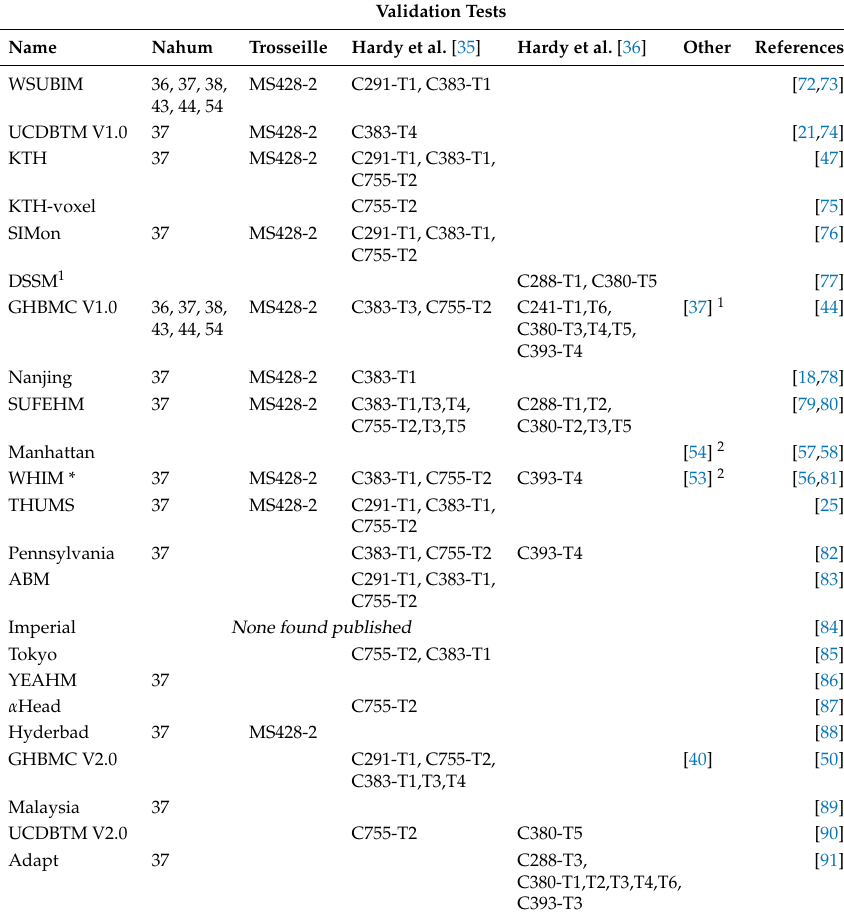
Table 4. A summary of the experimental procedures used to validate the intracranial response of existing Finite Element Head Models (FEHM), with reference to the papers detailing the procedures and performance. Where models do not have a published or generally used name, the location of the institute of the lead author(s) has been used to identify the FEHM. The FEHM are displayed in chronological order, according to the date of their initial validation